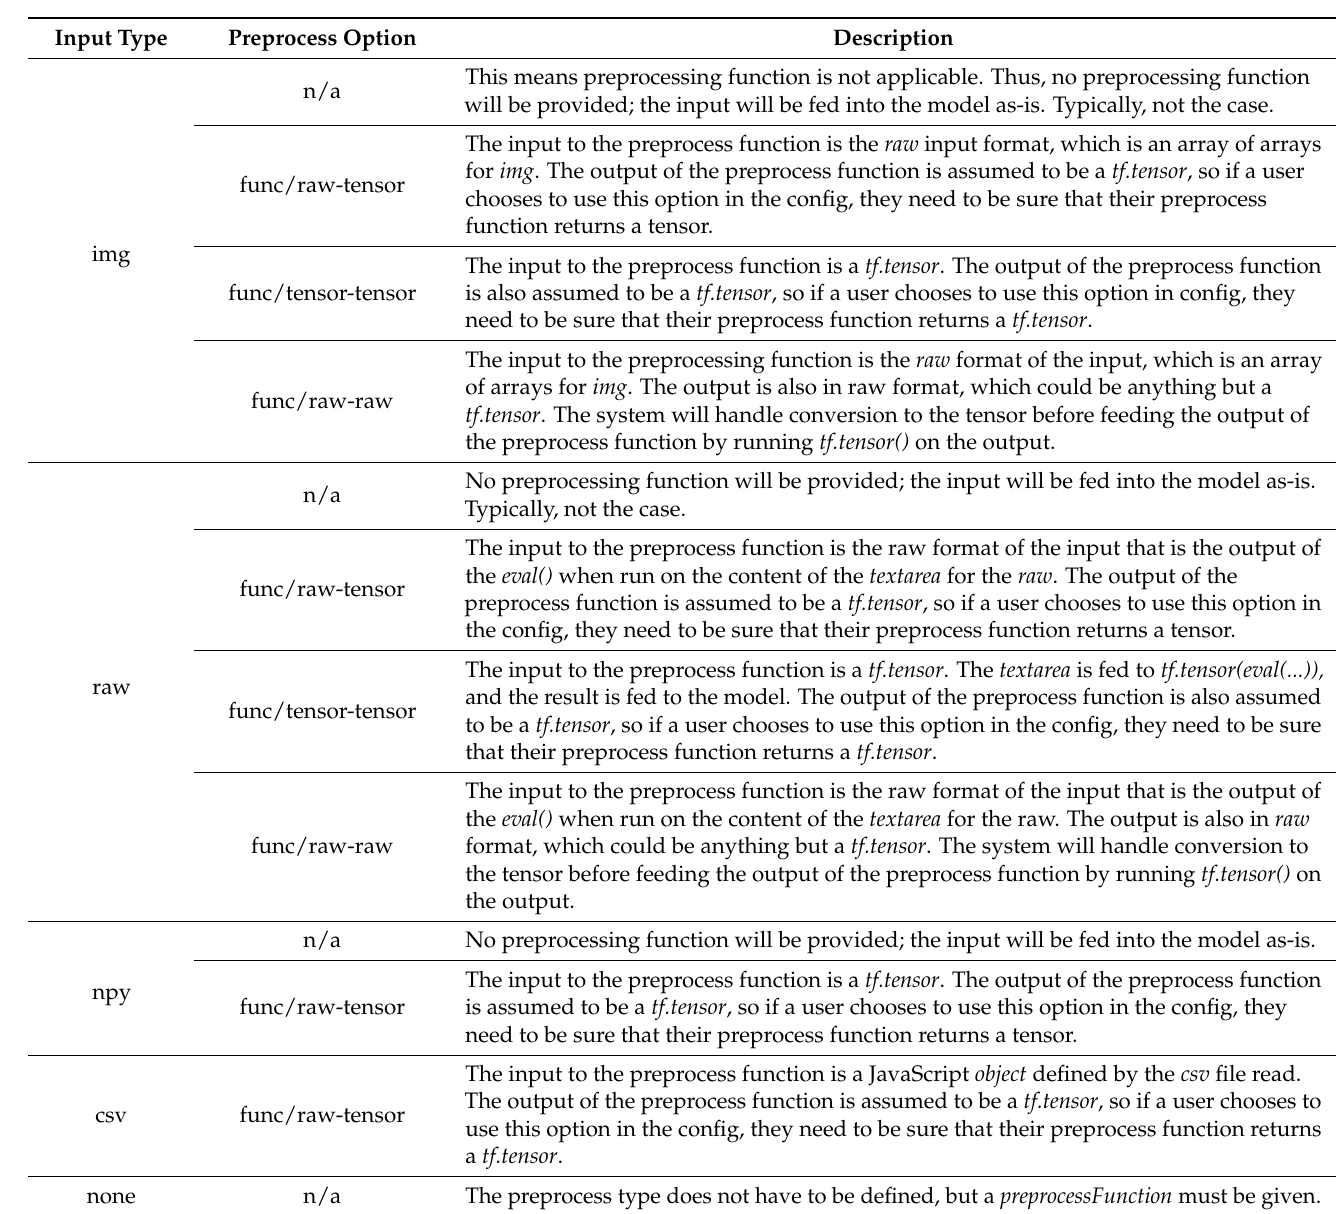
Table A3. Input types and their